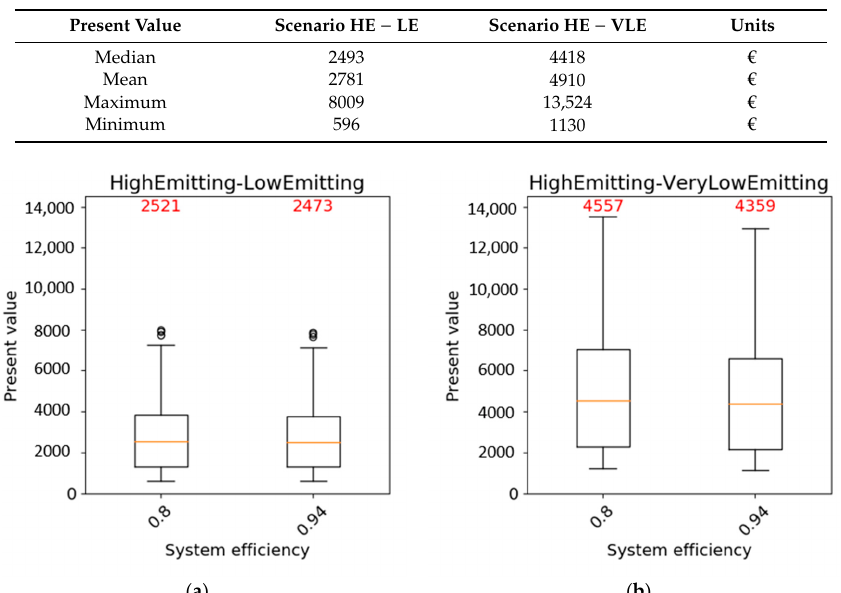
Table 6. Overall economic results.